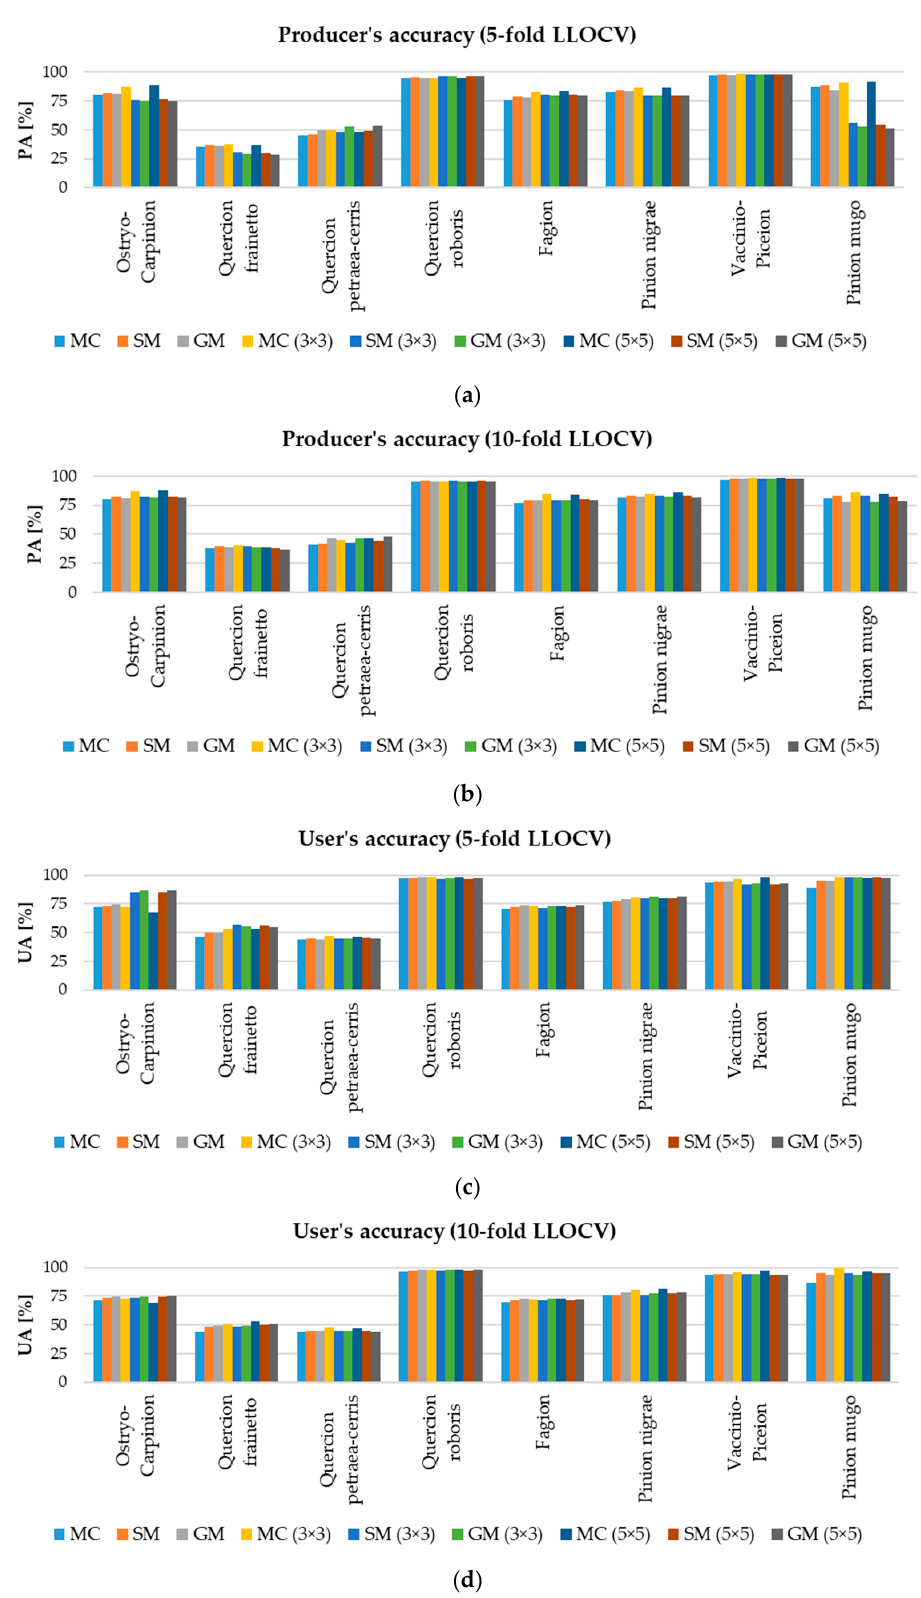
Figure 5. Producer’s accuracy and user’s accuracy barplots after K-fold leave-location out cross-validation ( a ) PA with K = 5 ( b ) PA with K = 10 ( c ) UA with K = 5 ( d ) UA with K = 10.